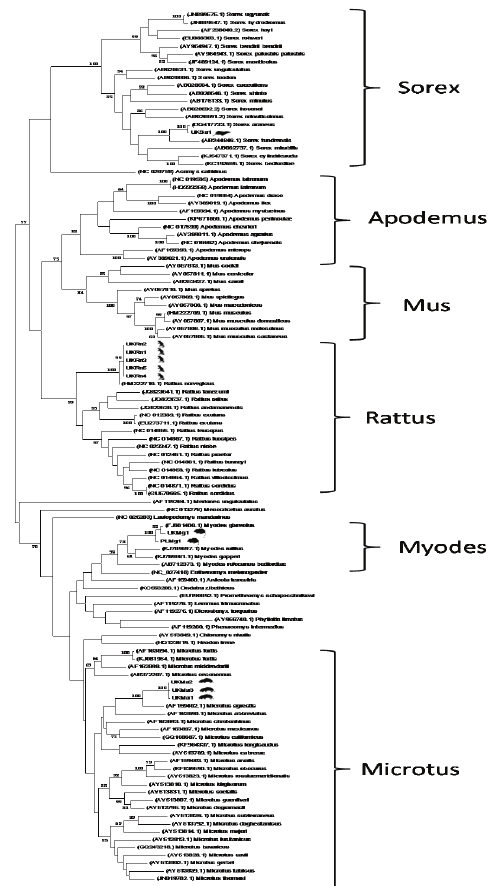
Figure 3. Maximum likelihood phylogenetic analysis of partial rodent cytochrome b nucleotide sequences. Host cytochrome b sequences obtained from CoV positive UK-resident Rattus norvegicus (UK Rn ), Microtus Agrestis (UK Ma ), Sorex araneus (UK Sa ) and Poland-resident (PL Mg ) or UK-resident (UK Mg ) were analysed alongside reference sequences representing rodent and shrew cytochrome b sequences. Reference sequences are indicated by their Genbank Accession Number. Branch lengths are drawn to scale: the bar indicates 0.05 nucleotide substitutions per site. Numbers above individual branches indicate the percentage that that branch was found in 1000 bootstrap replicates; only percentages >60 are shown. Table 2. Pairwise percentage nucleotide (upper quadrant) and deduced amino acid (lower quadrant) similarities of the novel rodent and shrew Coronavirus (CoVs) and the Lucheng Rn CoV across a region of the ORF1ab gene corresponding to positions 8331-8960 on the Lucheng Rn isolate (Genbank Accession number KF294380). Comparisons were made using unique nucleotide sequences. Sequence identifiers are the same as those shown in Figure 2.